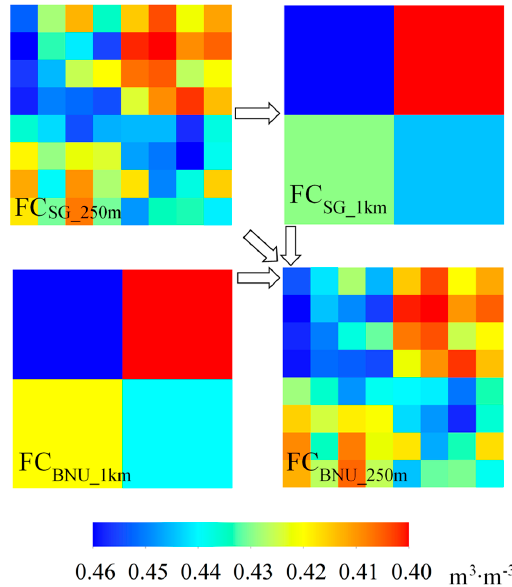
Figure 4. Scale matching for field capacity ensemble members. FC BNU_1km represents original BNU-based field capacity, FC SG_250m represents original SG-based field capacity, FC SG_1km represents upscaled mean values of FC SG_250m in corresponding grid, and FC BNU_250m represents downscaled field capacity based on BNU.